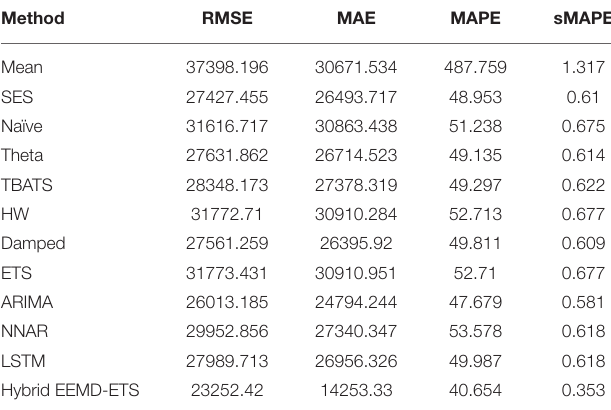
TABLE 7 | Performance comparison of different models for 7 days prediction of France’s confirmed